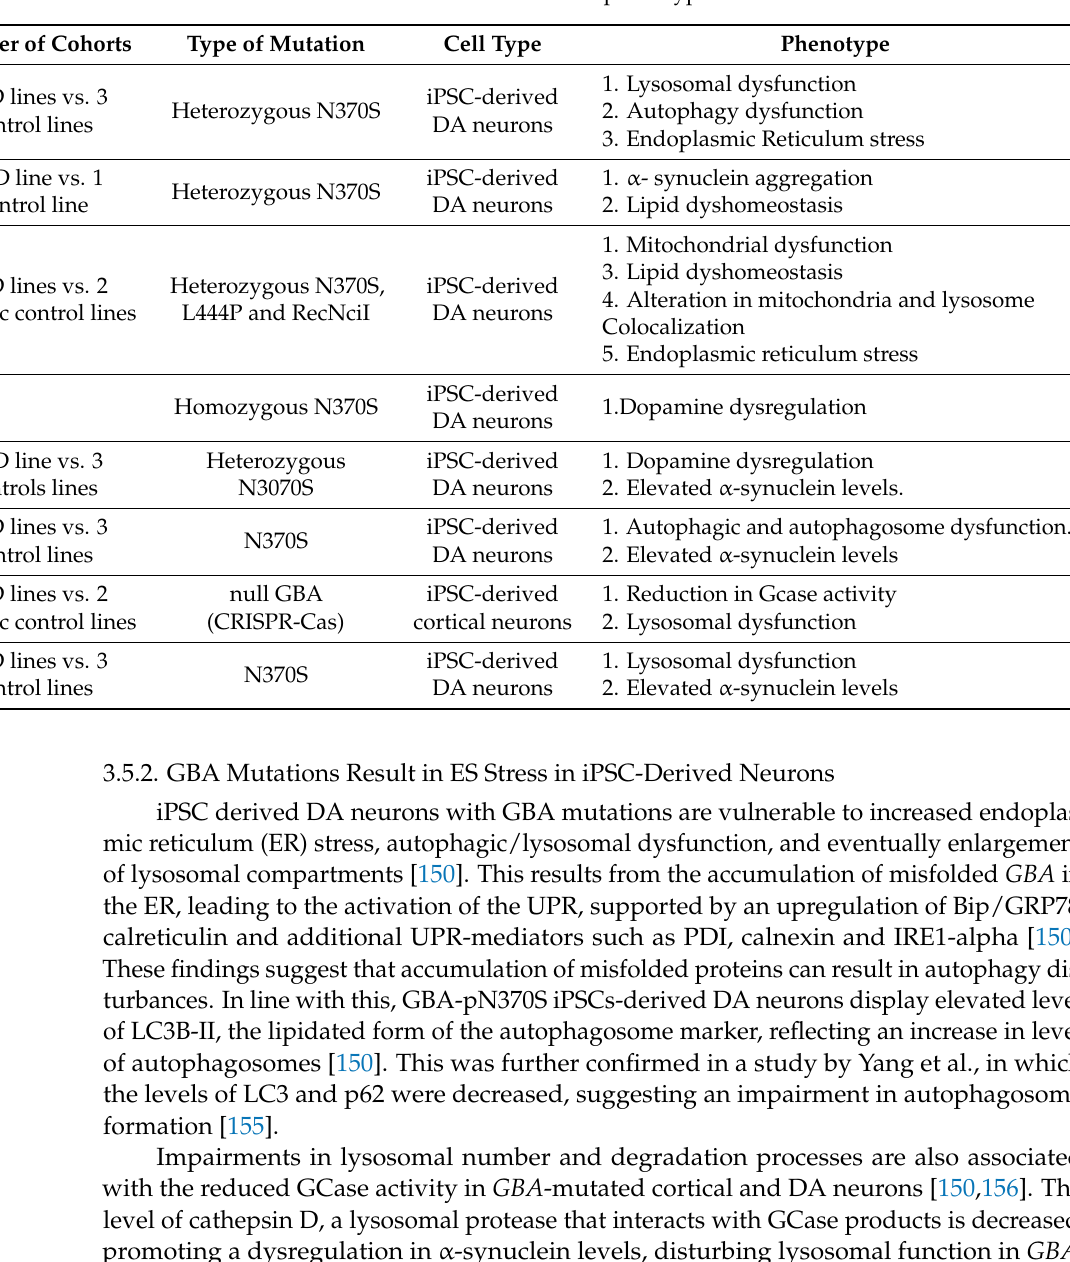
Table 5. GBA-mutated iPSC-derived neuronal